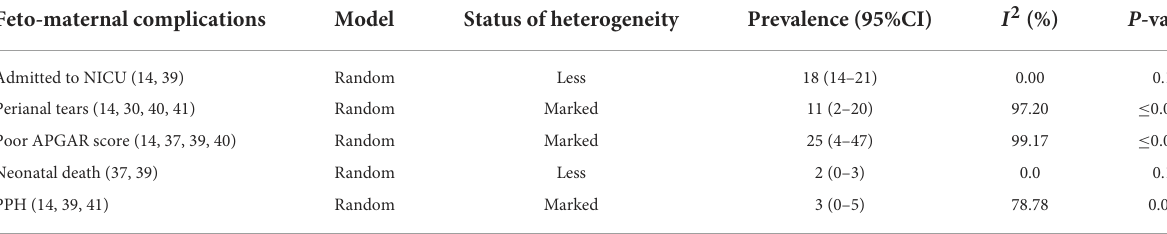
TABLE 5 Feto-Maternal complications following OVDs among women who gave births by OVD in Ethiopia, 2022. Feto-maternal